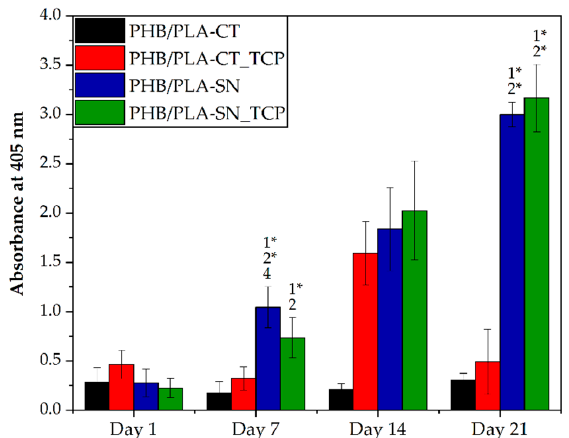
Figure 7. The results of ALP assay. The numbers above the column indicate statistically significantly higher values compared to the column of that number for p < 0.05 and p < 0.001 with *. The expression of typical osteogenic markers was monitored via real-time PCR analysis and is shown in Figure 8.